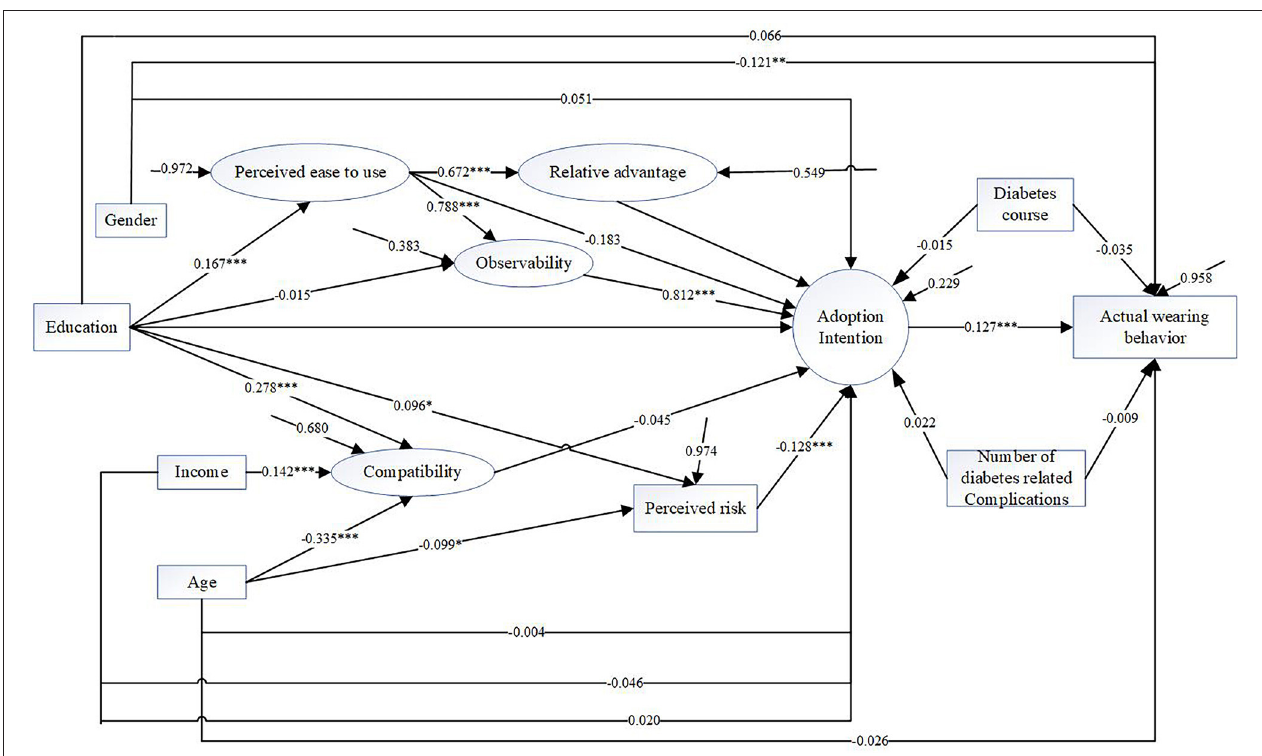
FIGURE 3 | Results of structural equation model for actual wearing